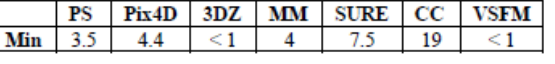
Figure 6: Comparison of dense point cloud number of points- Agisoft Photoscan Professional (PS), Pix4D, 3Df Zephyr (3DZ), SURE, MicMac (MM), VisualSFM (VSFM), and ContextCapture (CC) (Aicardi et al., 2016)